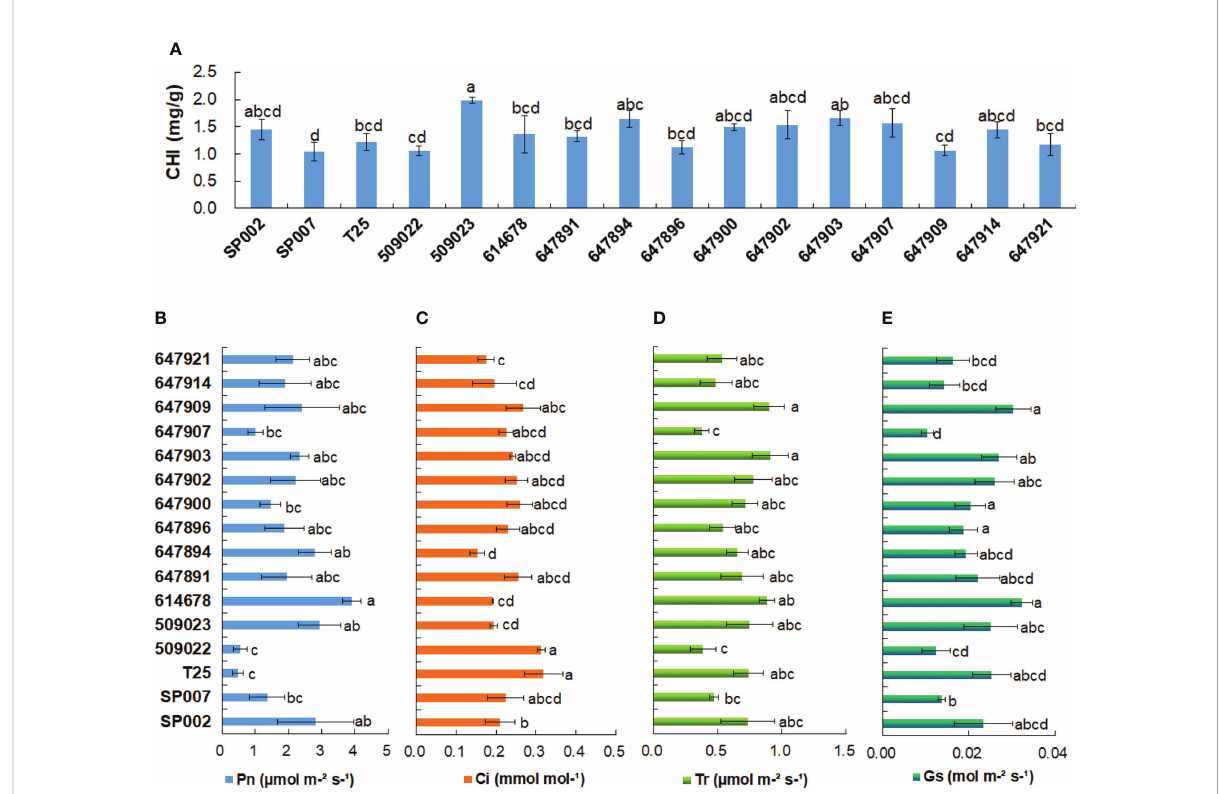
FIGURE 3 Chlorophyll contents and photosynthesis-related parameters analysis of 16 seashore paspalum ecotypes. Chlorophyll contents (A) , net photosynthetic rate (Pn) (B) and intercellular CO 2 concentration (Ci) (C) , transpiration rate (Tr) (D) , and stomatal conductance (Gs) (E) were measured by LI-6400-40 portable photosynthesis system when 16 seashore paspalum ecotypes grown in the greenhouse for 8 weeks. Means of three replicates and standard errors are presented; the same letter above the column indicates no signi fi cant difference at P